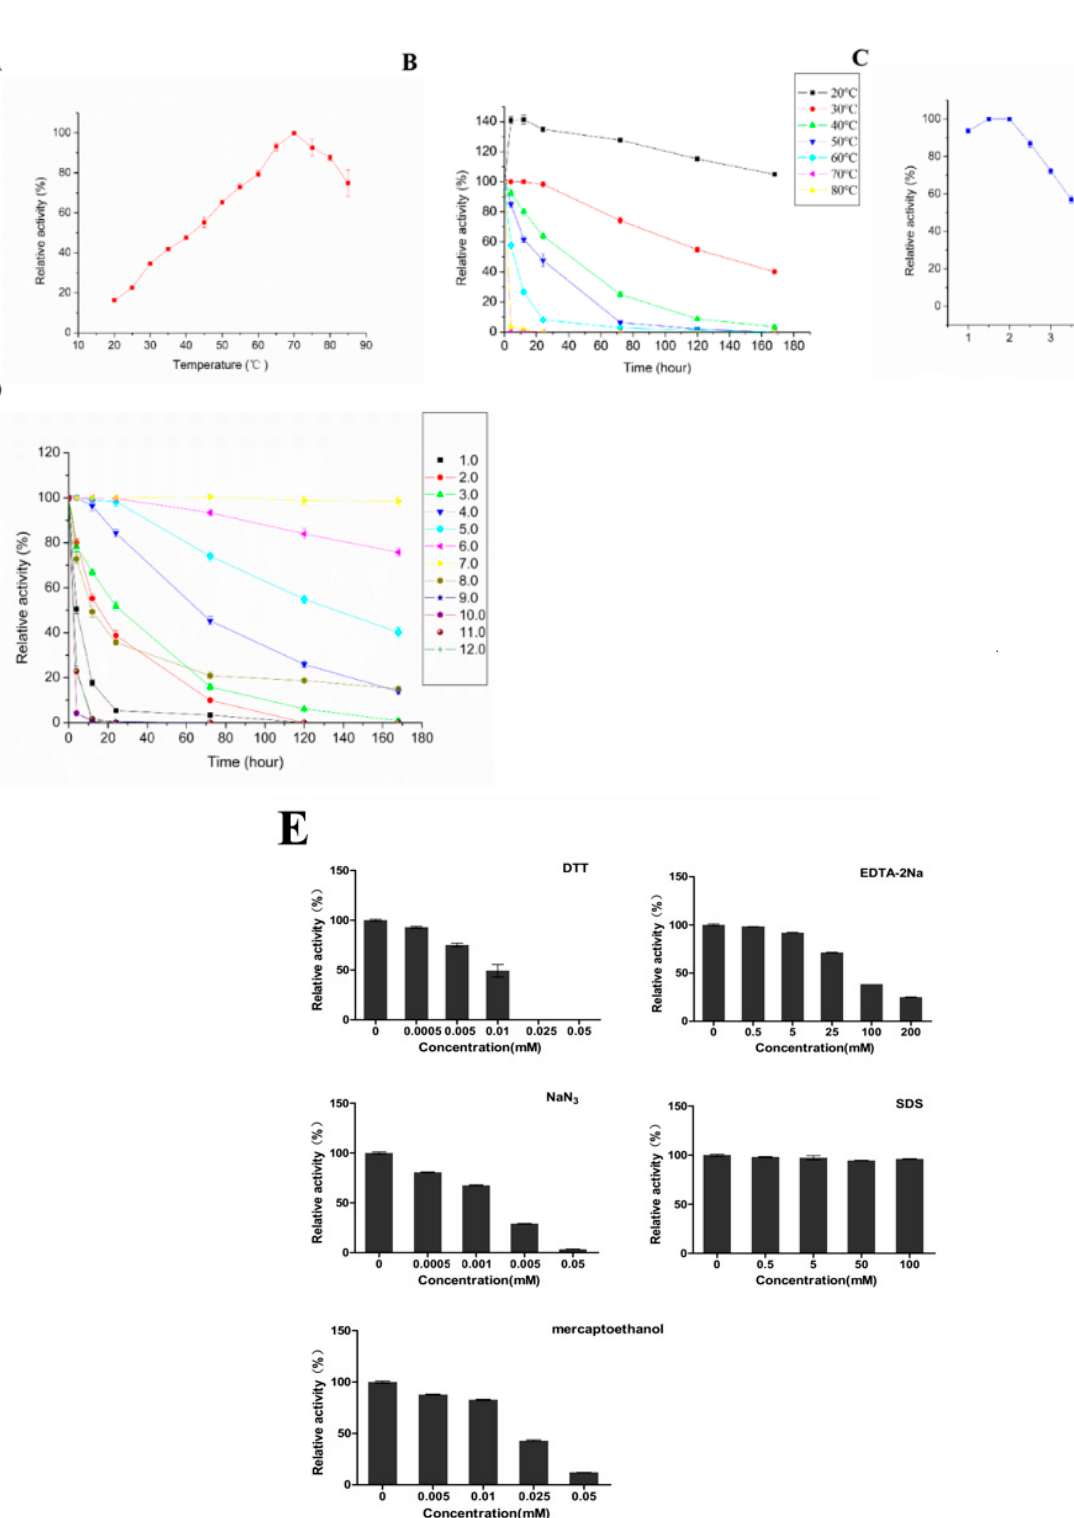
Figure 2. Enzymatic properties of purified LAC-4 laccase. ( A ) Effects of different temperatures on LAC-4 activity. ( B ) Effects of different temperatures on LAC-4 stability. ( C ) Effects of different pH on LAC-4 activity. ( D ) LAC-4 stability at different pH values. ( E ) Effects of different inhibitors (SDS, EDTA-2Na, DTT, NaN 3 , and mercaptoethanol) on LAC-4 laccase activity.